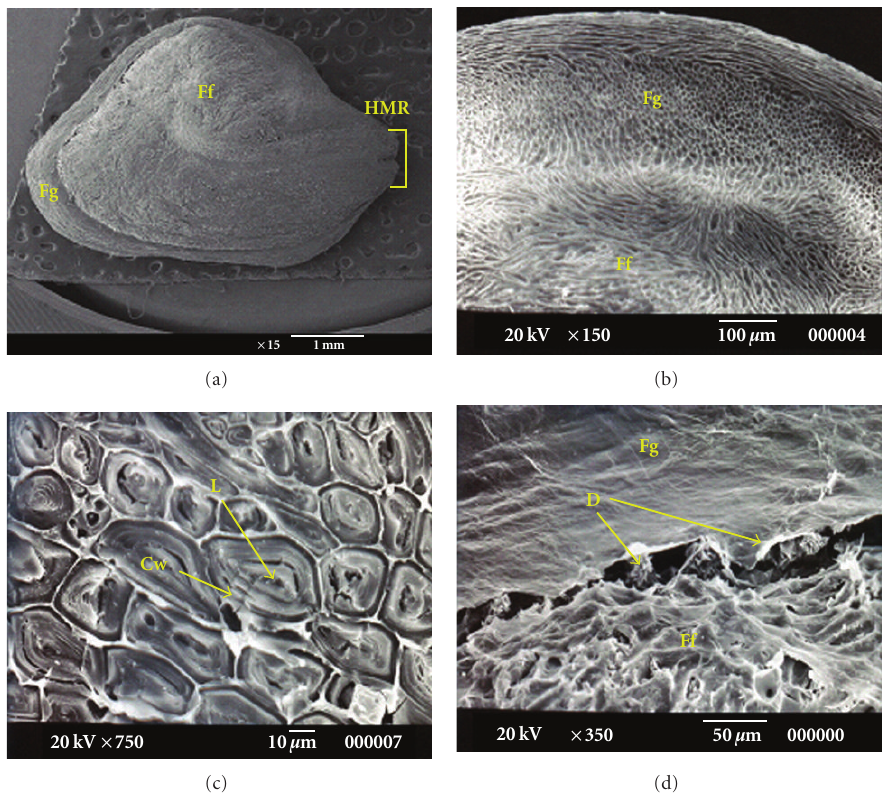
Figure 3: Micrographs of Opuntia tomentosa seeds recently taken from the fruit and washed with water: (a) whole seed; (b) fibers of the funicular seed cover; (c) funicular cell walls in a transversal cut; (d) druses in the funicular seed cover and the remains of the soft funicle. Cw: cell walls; D: druses, Ff: funicular flanks, Fg: funicular girdle, HMR: hilum-micropylar region, L: lumen.